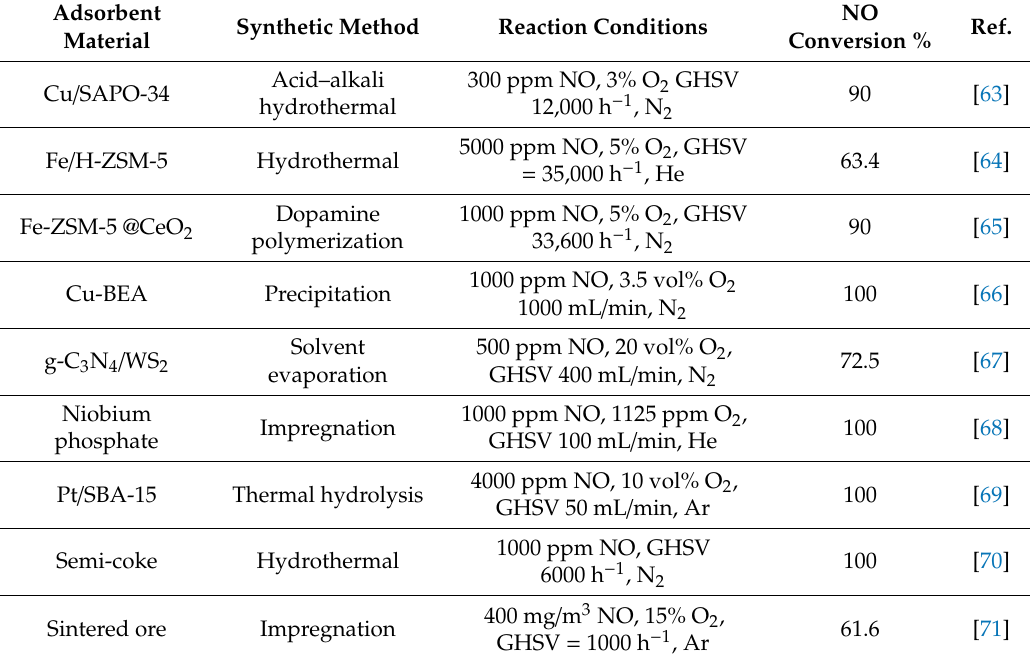
Table 2. E ff ect of di ff erent adsorbents on removal of NO x